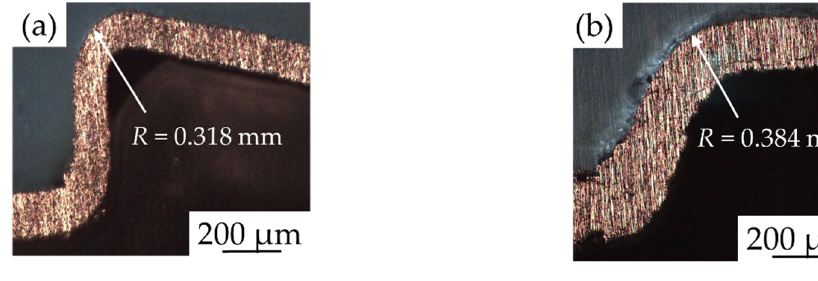
Figure 28. Radius shape of the corner of the deformed tubes: ( a ) taper-shaped tube; ( b ) cylinder-shaped tube.